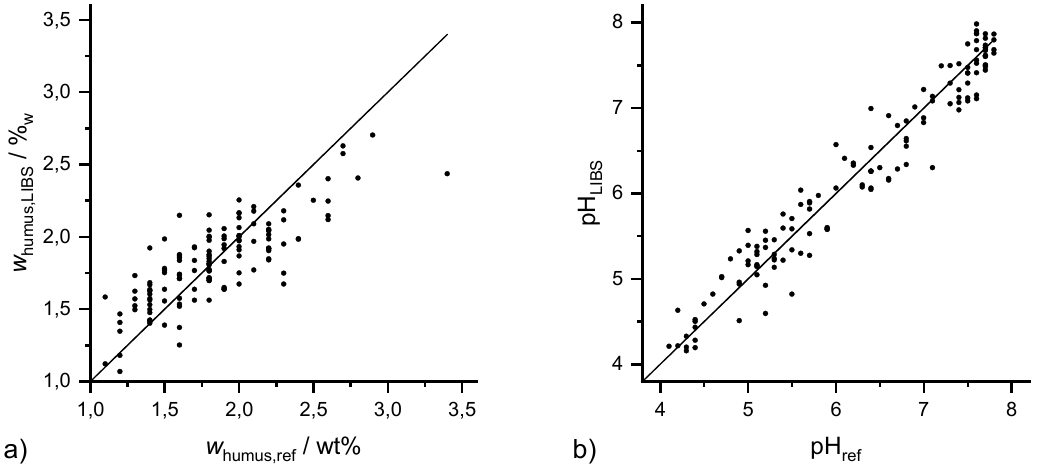
Figure 7. ( a ) Results of 10-fold Lasso cross validation for humus with R 2 (humus, Lasso) = 0.66 and ( b ) 10-fold GPR cross validation for pH value with R 2 (pH, GPR) = 0.95.